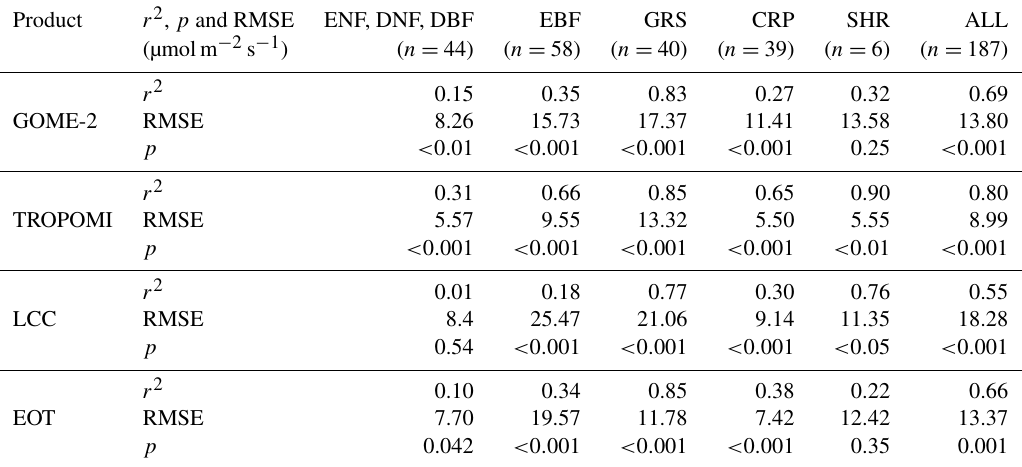
Table 1. Correlations by plant function type between V cmax at growing season mean temperature ( T g ) in four products (GOME-2 SIF, TROPOMI SIF, LCC, and EOT) and a ground database with 3672 individual data points aggregated to 180 grids of 0.5 ◦ resolution. ENF signifies evergreen needleleaf forest, DNF deciduous needleleaf forest, DBF deciduous broadleaf forest, EBF evergreen broadleaf forest, GRS grassland, CRP cropland, SHR shrub, and RMSE root mean square